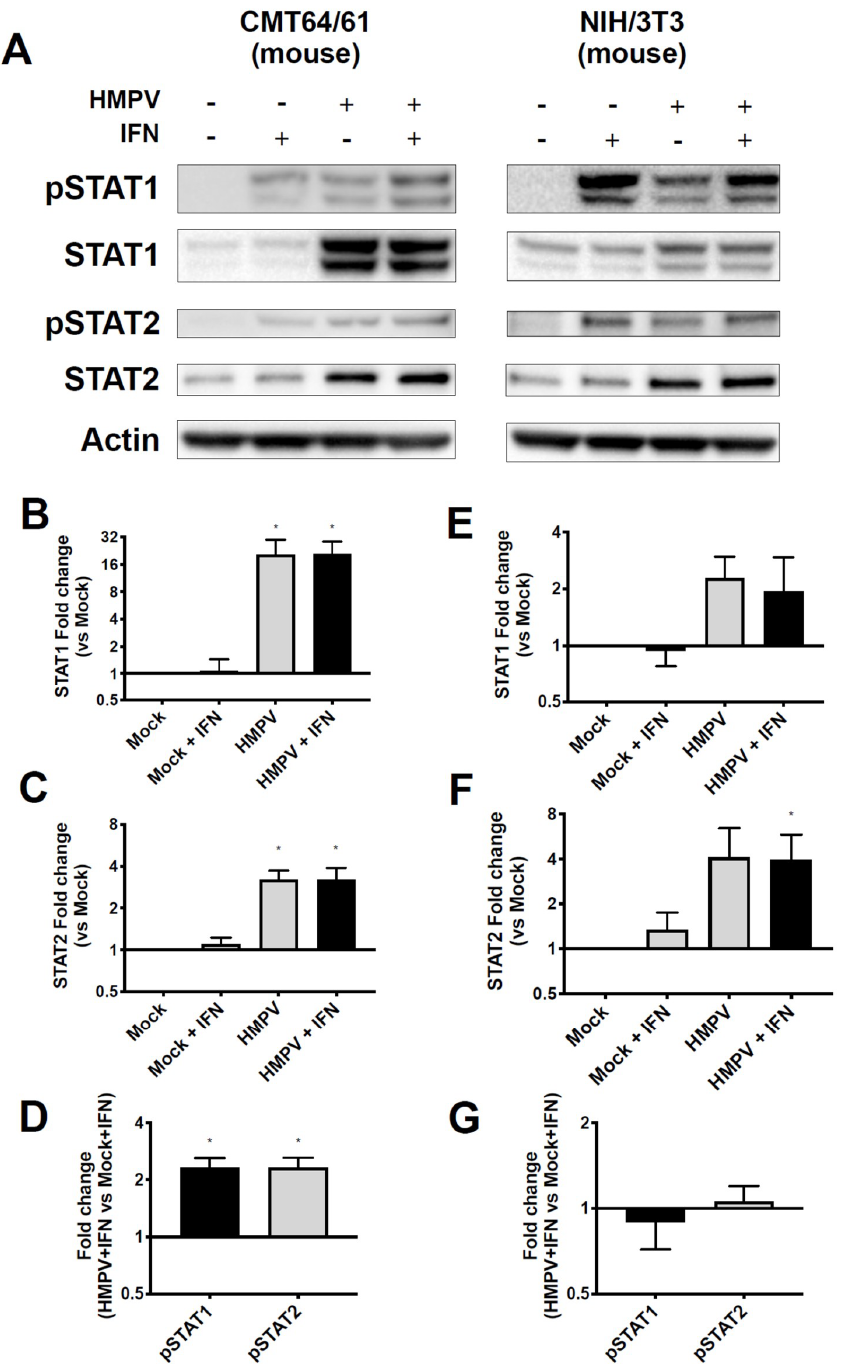
Figure 4. HMPV infection of murine cells leads to upregulation and phosphorylation of STAT1 and STAT2. ( A ) CMT64/61 (murine), left, and NIH3T3 (murine), right, cells were infected with HMPV for 24 h, then treated with IFN for 30 min before cells were lysed for Western blotting against total and phosphorylated STAT1 and STAT2. ( B , C ) Fold change of total STAT1 and STAT2 expression compared to mock-infected wells for CMT64/61 cells. ( D ) Fold change of pSTAT1 and pSTAT2 compared to mock-infected wells in CMT64/61 cells. ( E , F ) For NIH3T3 cells, fold change of STAT1 and STAT2 compared to mock-infected wells. ( G ) Fold change of pSTAT1 and pSTAT2 compared to mock-infected cells in NIH3T3 cells. * p < 0.05, one sample t test comparing samples to normalized mock value of 1. Data are representative of ( A ) or combined from four ( B – D ) or two ( E – G ) independent experiments.